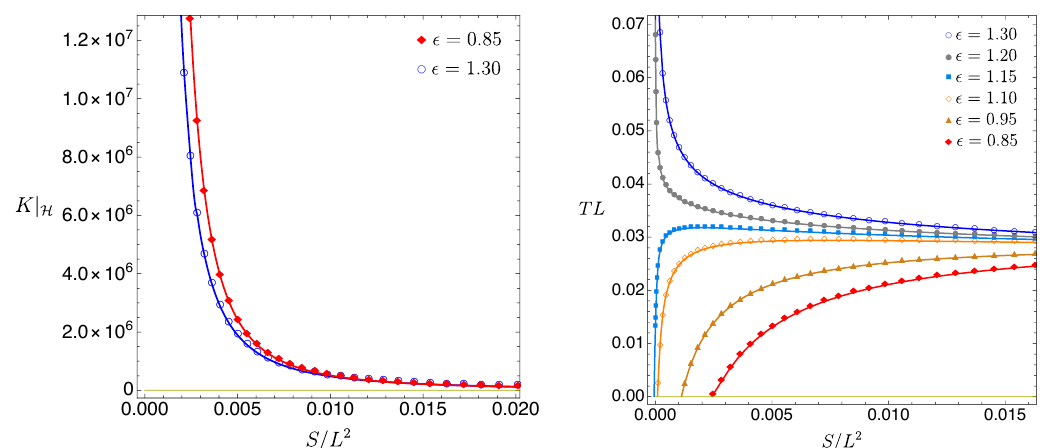
Figure 8 . Kretschmann curvature at the horizon (left panel) and temperature (right panel) as a function of the entropy ( S/L 2 = πR 2 ) for hairy BH families with fixed (cid:15) and scalar field charge + e = 2 ( e c ≤ e < e S